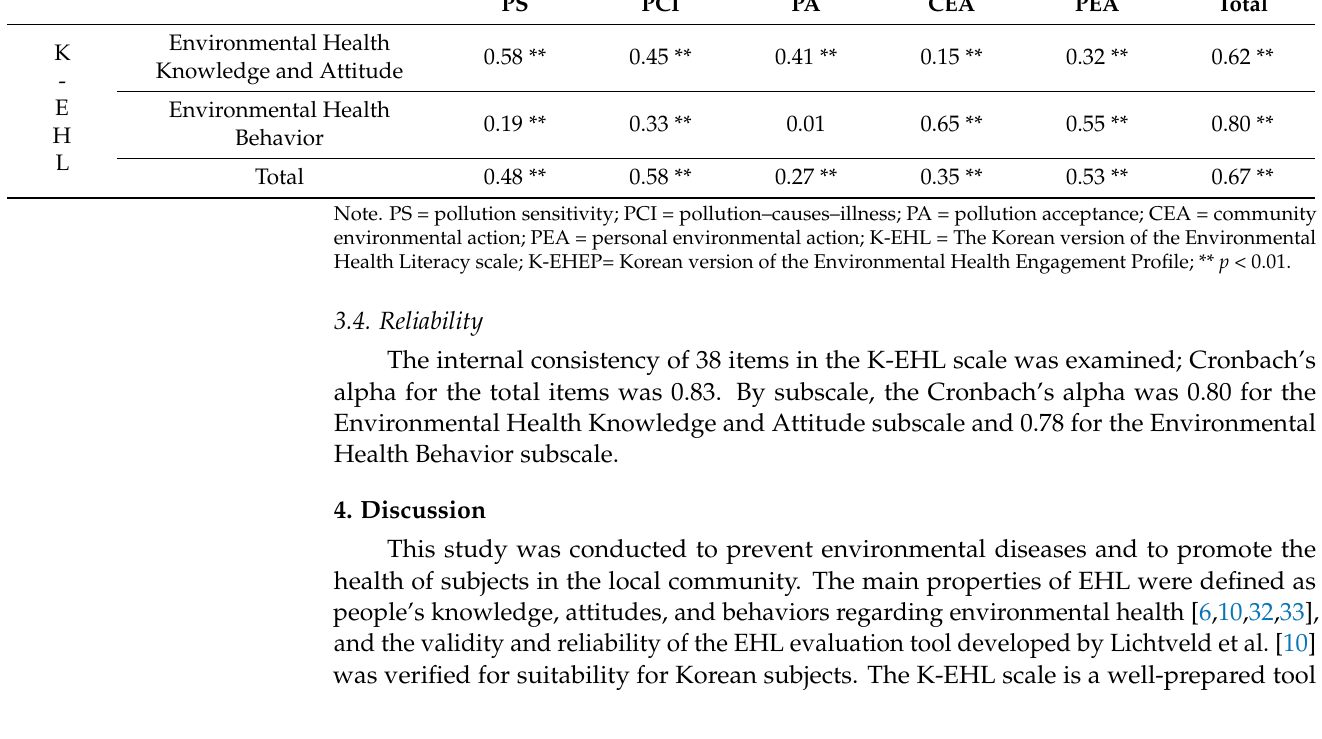
Table 5. Correlation between the K-EHEP and K-EHL scale by subscales ( n = 492).